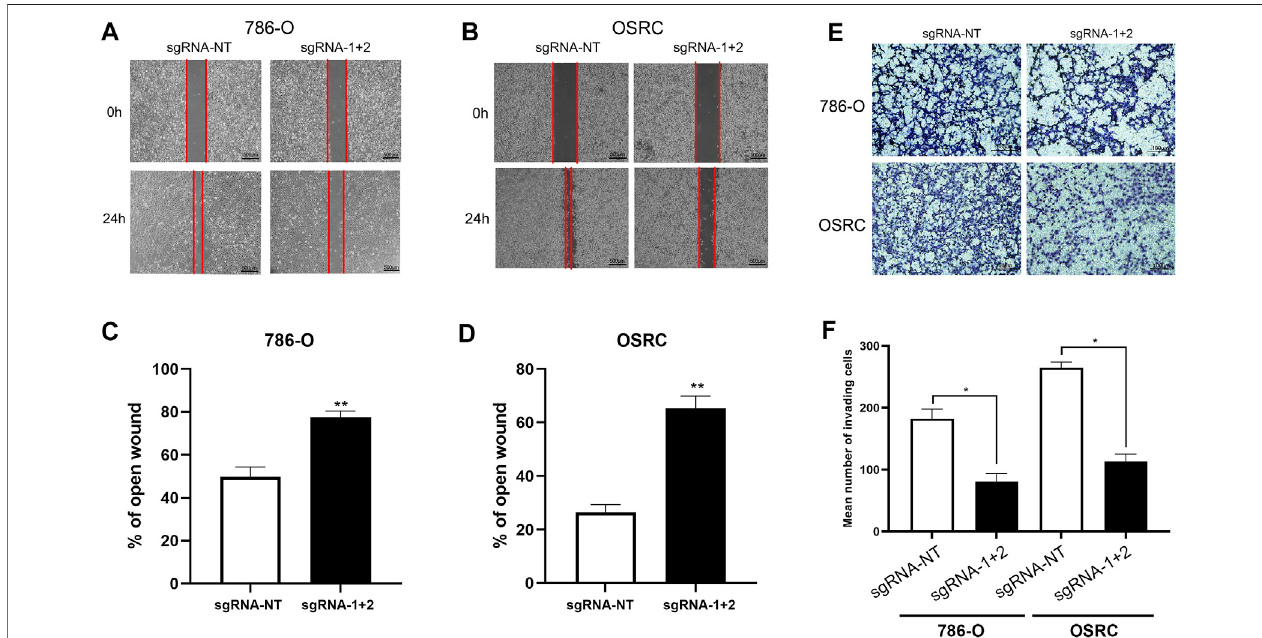
FIGURE 4 | Hypermethylation of LncRNA NEAT1 repressed the RCC cells migration. (A-D) Wound-healing assays for migration ability of 786-O and OSRC cells aftertransfectedwithdCas13b-METTL3andsgRNAs. (E,F) Transwellassaysformigrationabilityof786-OandOSRCcellsaftertransfectedwithdCas13b-METTL3and sgRNAs. * p <